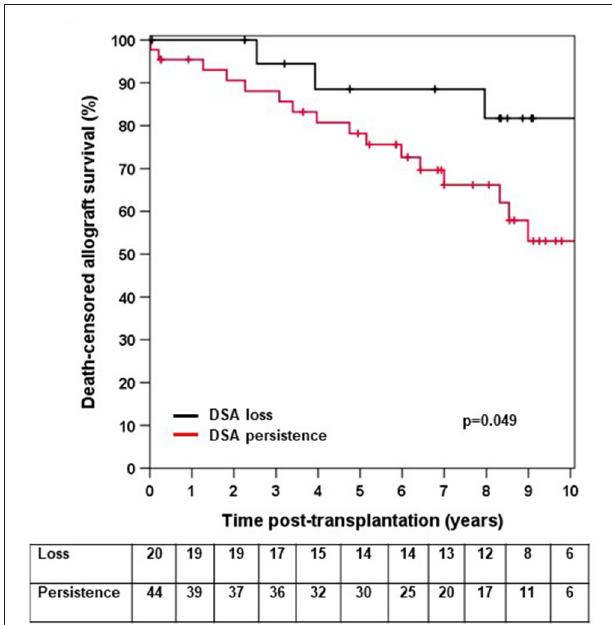
FIGURE 3 | Death-censored allograft survival in DSA-positive patients in whom DSA were undetectable 14 days post-transplant (loss) or who had persistence of DSA (persistence).